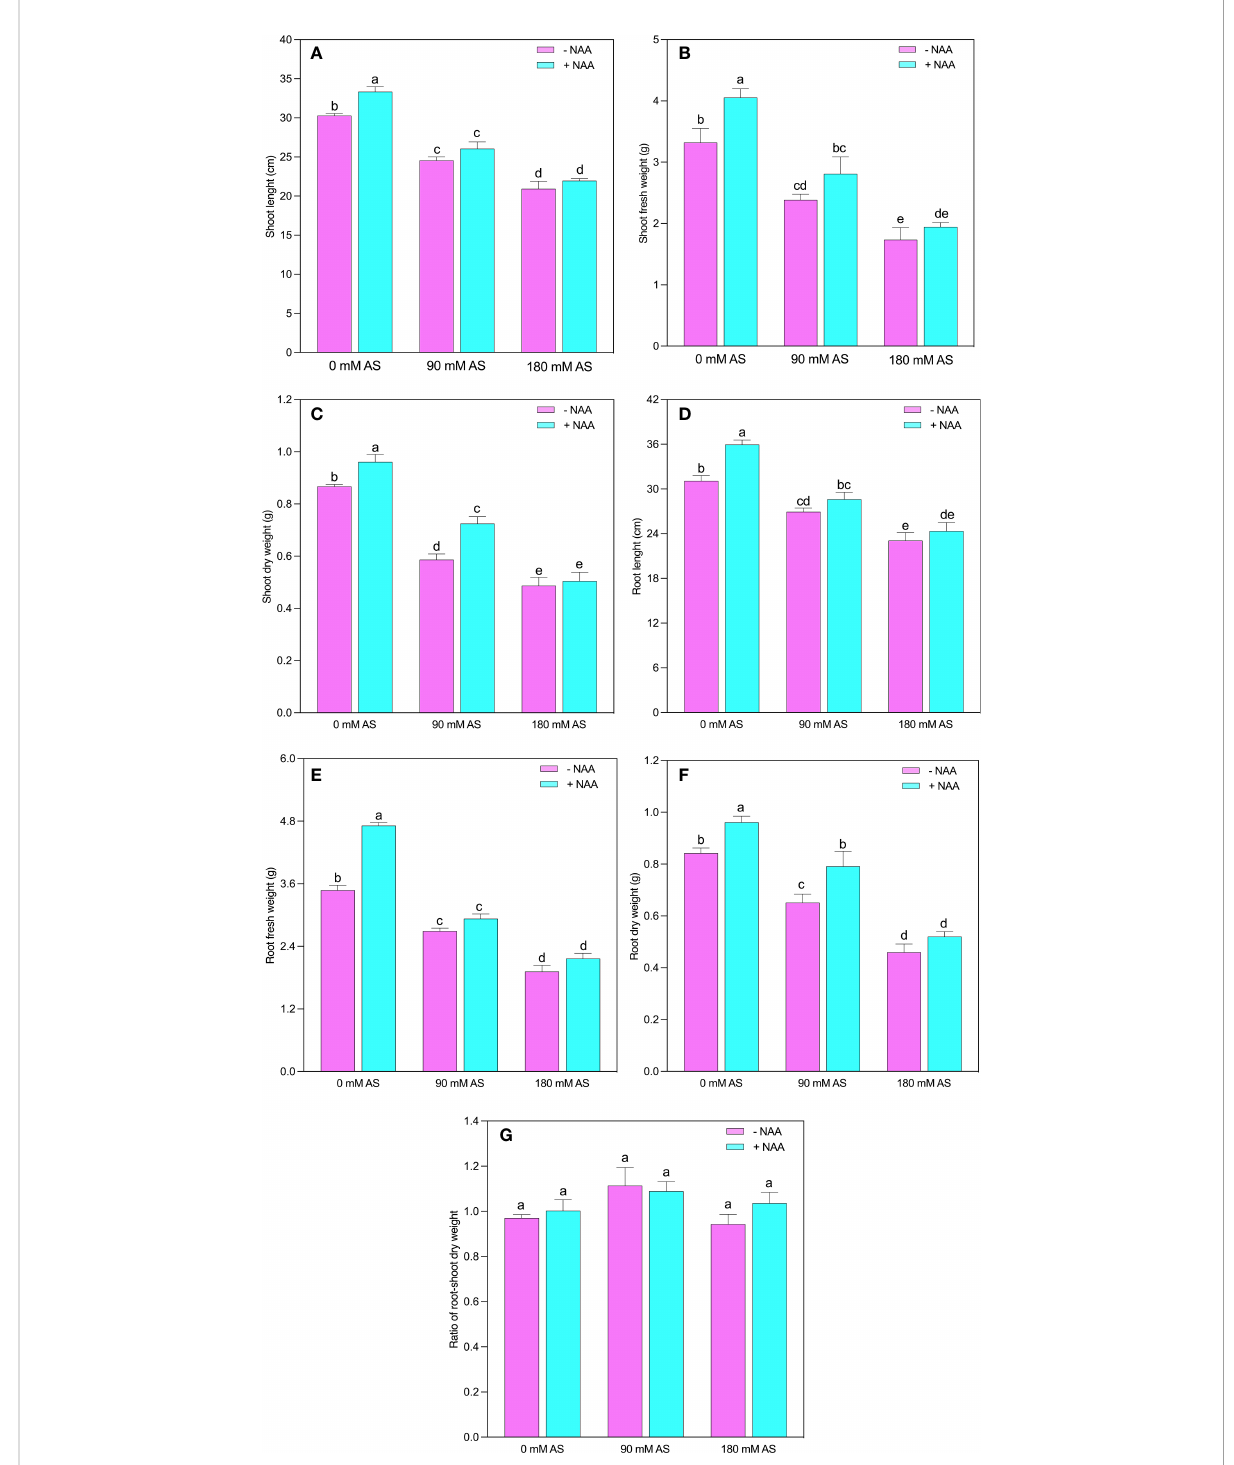
FIGURE 1 Changes in (A) shoot length, (B) shoot fresh weight and (C) shoot dry weight, (D) root length, (E) root fresh weight (F) root dry weight and, (G) root-shoot ratio of chufa plants under alkaline stress (AS) and exogenous naphthaleneacetic acid (NAA) application. Bars represents SD of mean, n=3. Different letters indicate signi fi cantly different values at P <0.05 (Duncan ’ s